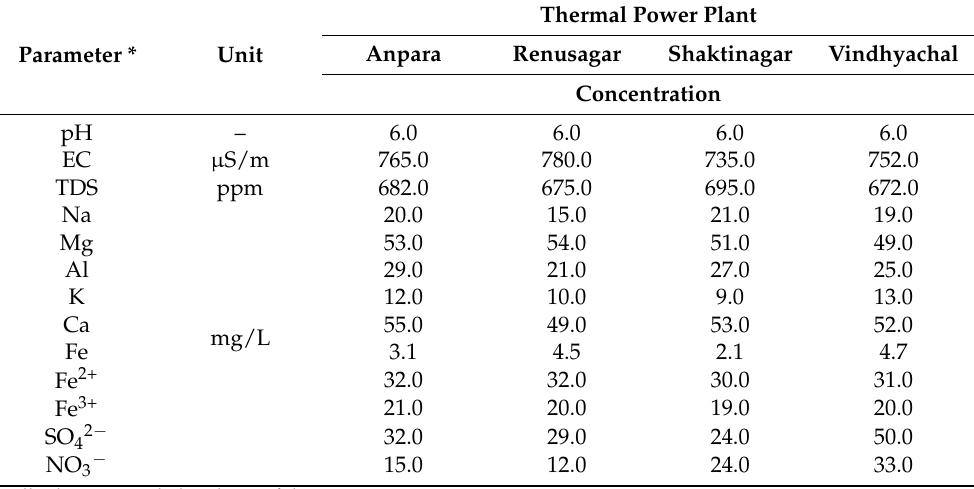
Table 4. Physicochemical characteristics of the AMD after addition of fly